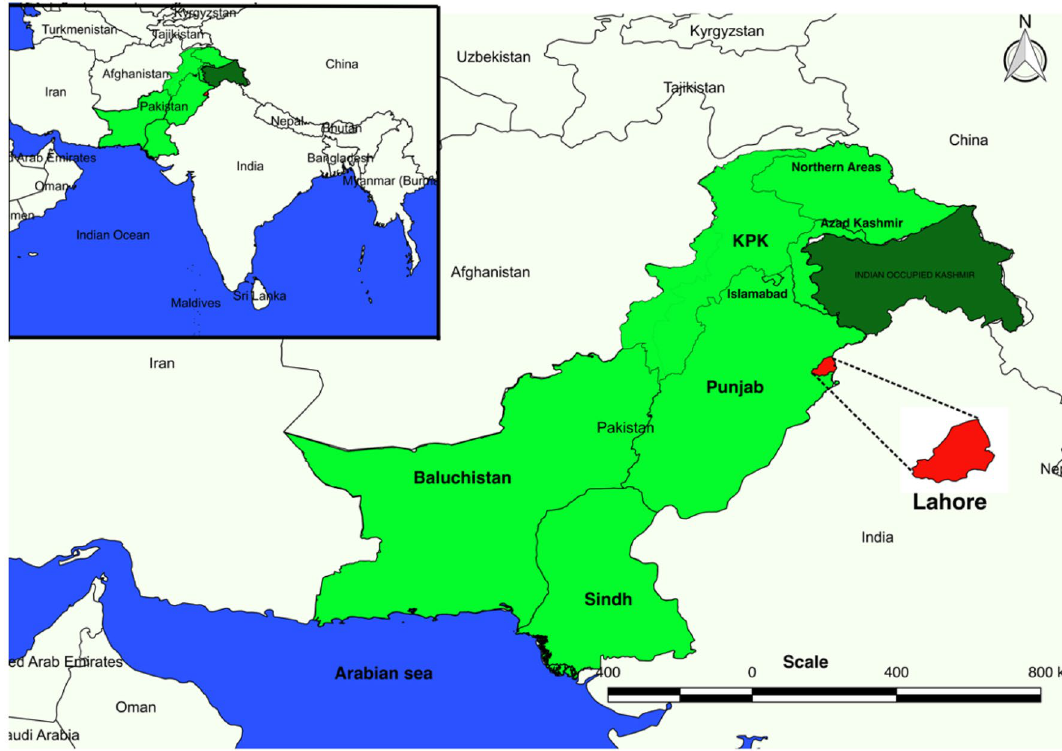
Figure 5. Political map of Pakistan, divided into four provinces, with Lahore magnified in red. The map was generated with a free and open- source software QGIS version 2.18.24 (GNU General Public License), developed by the Open Source Geospatial Foundation Project